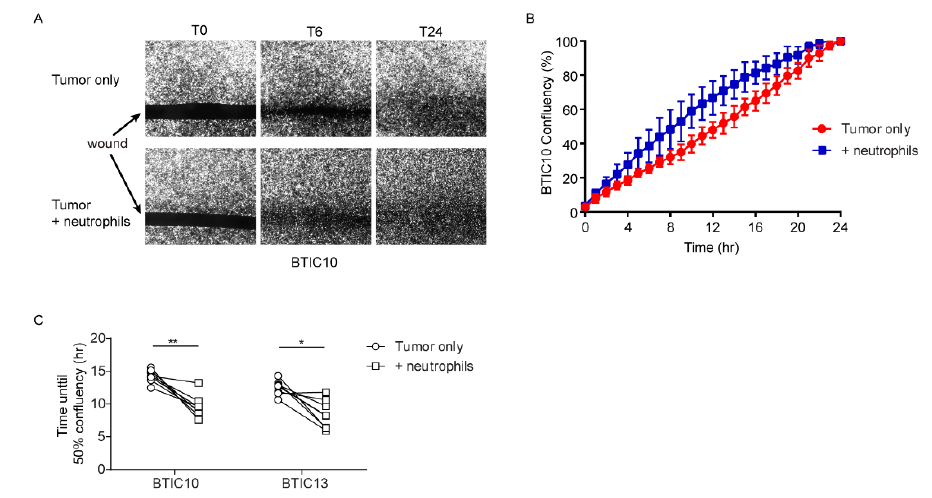
Figure 3. Neutrophils promote in vitro wound-closure of human glioblastoma tumor cells. ( A ) Rep- resentative images of BTIC13 at 0, 6, and 24 h after start of incubation in the wound-healing assay with or without neutrophils. Comparison of wound closure at 6 h shows increased migration